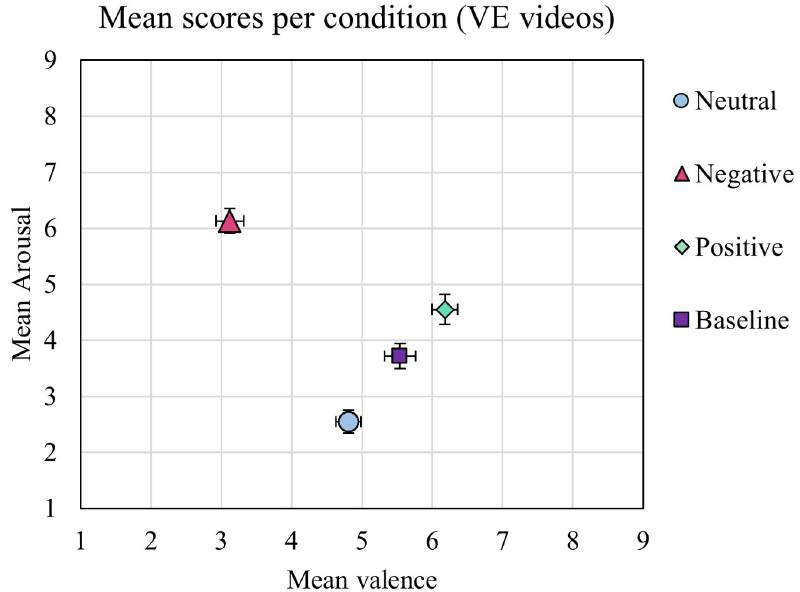
Fig 3. Mean valence and arousal ratings for each VE condition: Neutral VE (light blue circle), Negative VE (pink triangle), Positive VE (green diamond), Baseline VE (purple square). Error bars depict SE for each dimension.